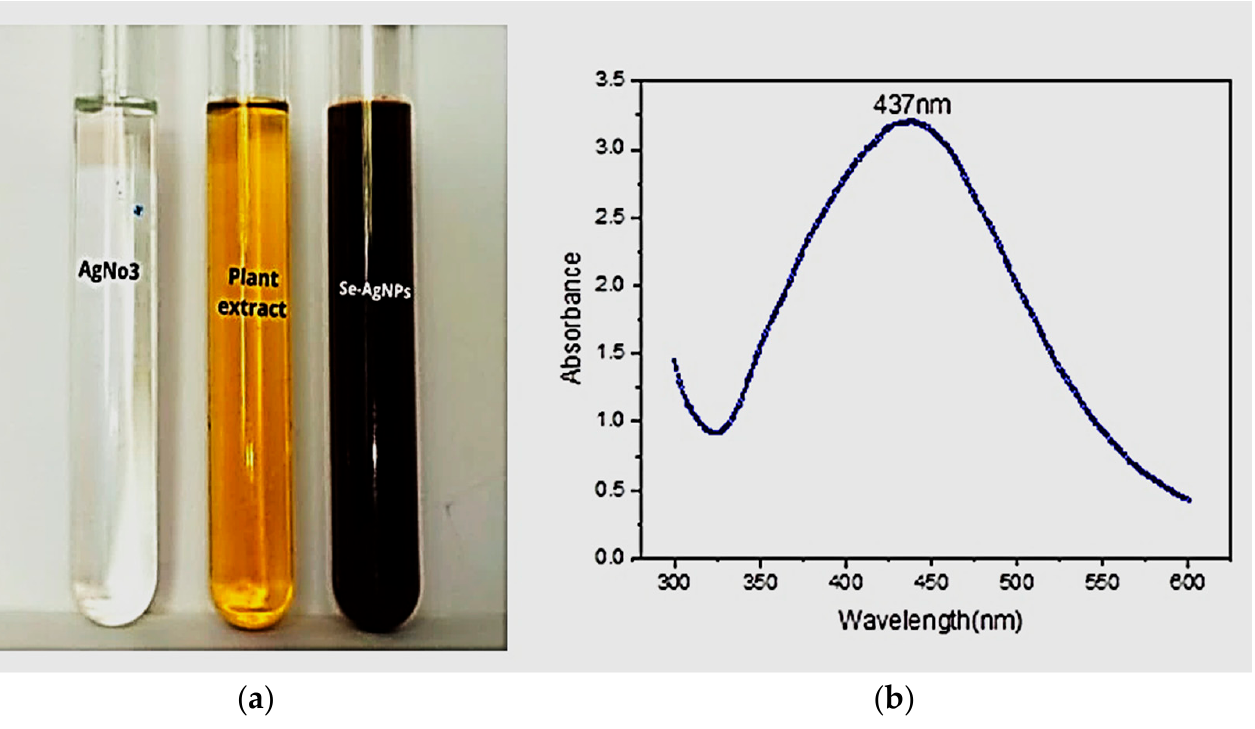
Figure 2. Color change to dark brown after exposing mixture to sunlight for 20 min ( a ), and UV-visible spectrum post-24 h of the reaction ( b ).